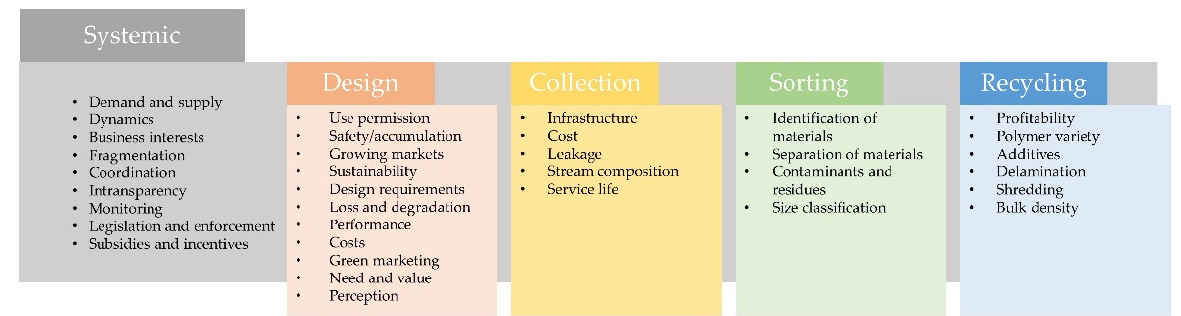
Figure 1. Hurdles to circularity of packaging focused on, but not limited to multilayer flexible packaging [7–9,13,14,19,21,26,30,33,35–76].